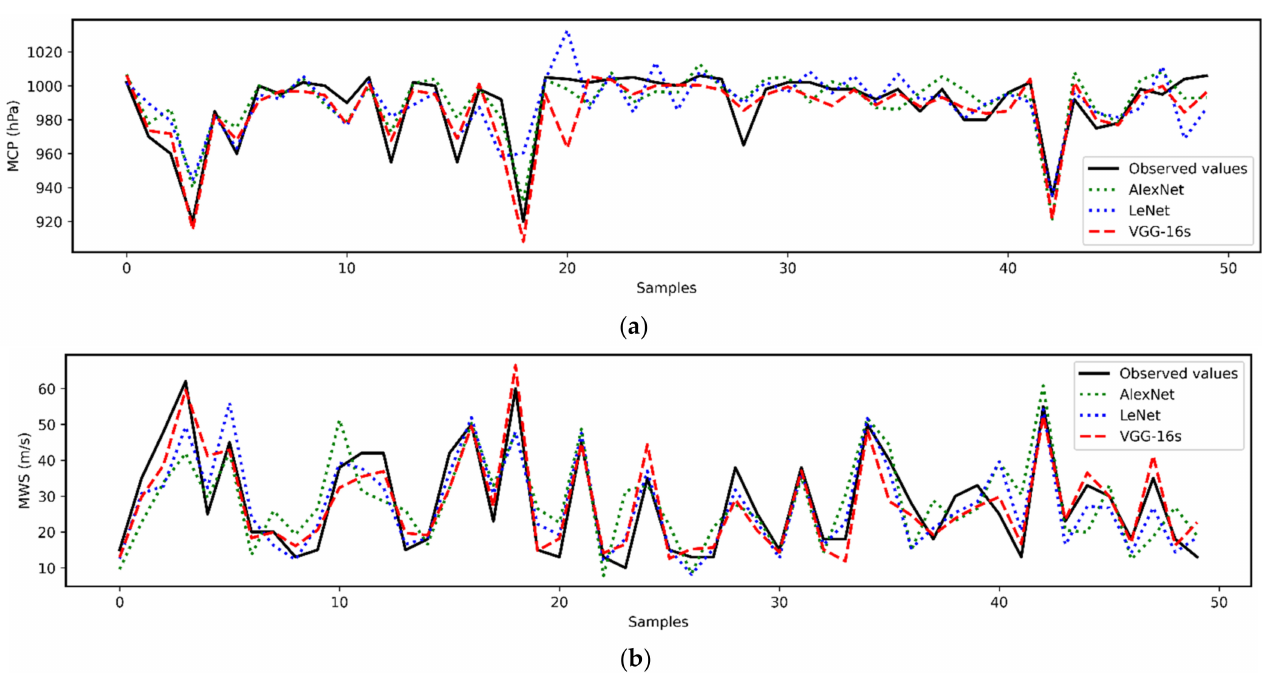
Figure 3. Comparison between observations and predictions from three models. ( a ) MCP. ( b )